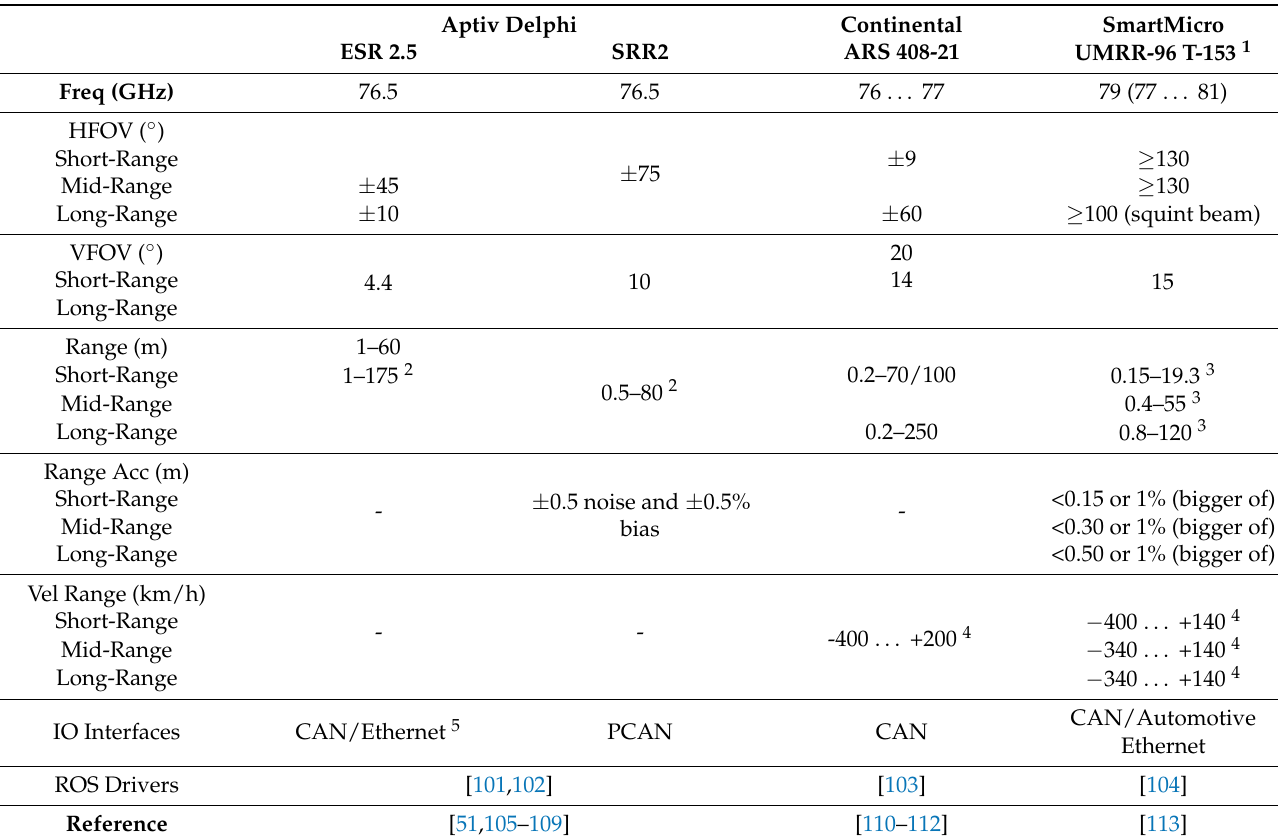
Table 4. Summary of the general specifications of radar sensors from SmartMicro, Continental and Aptiv Delphi. The acronyms (first column from top to bottom) are frequency (Freq), horizontal FoV (HFOV), vertical FoV (VFOV), range accuracy (Range Acc), velocity range (Vel Range), input/output interfaces (IO Interfaces) and ROS (Robotic Operating System) drivers for that specific sensors. The “-” symbol in table indicates that the specifications were not mentioned in product